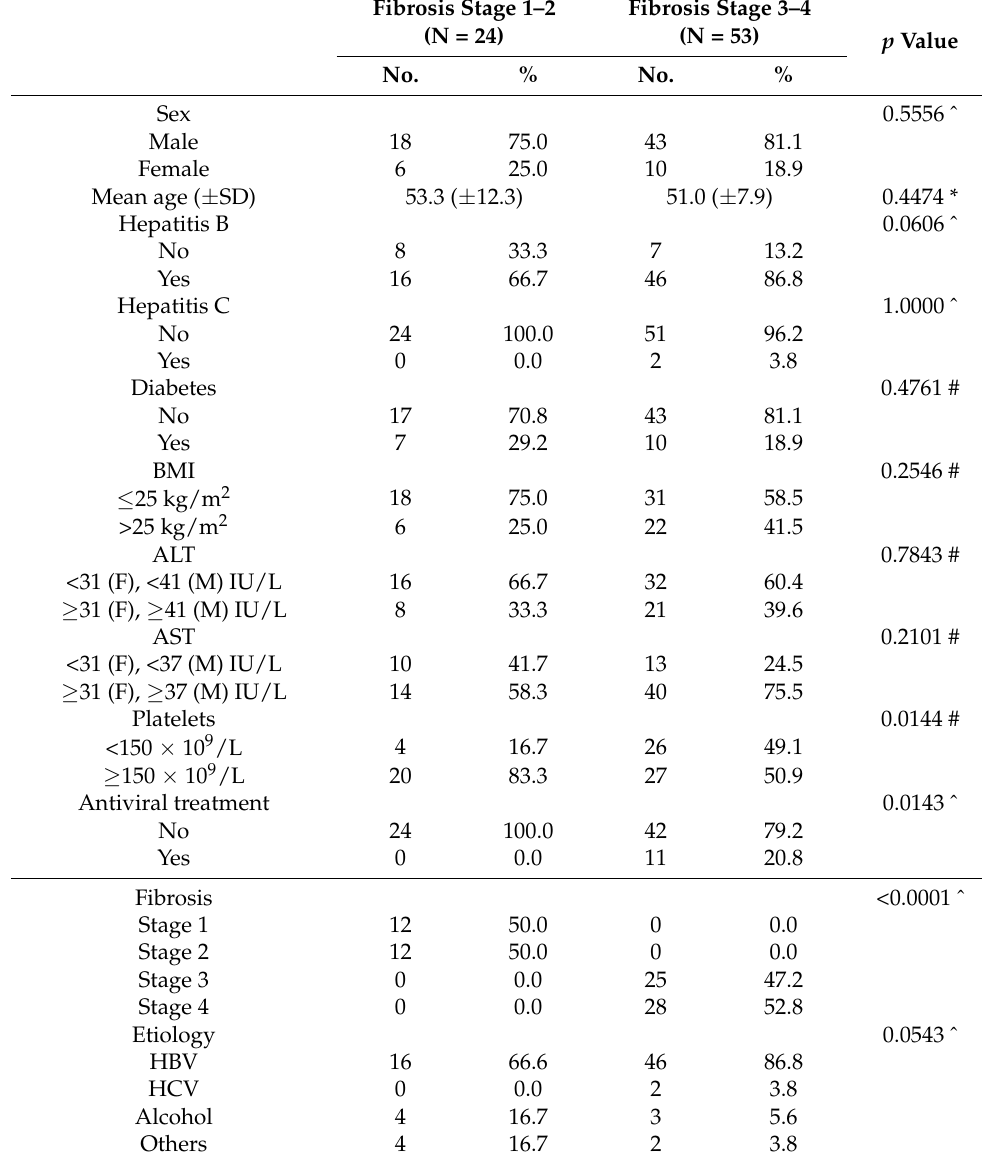
Table 1. Baseline characteristics of enrolled